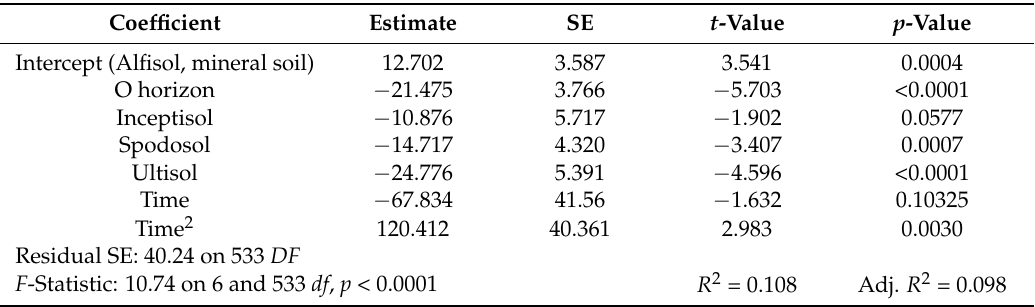
Table 2. Linear regression coefficients and significance for second degree polynomial model of response of soil C to harvesting over